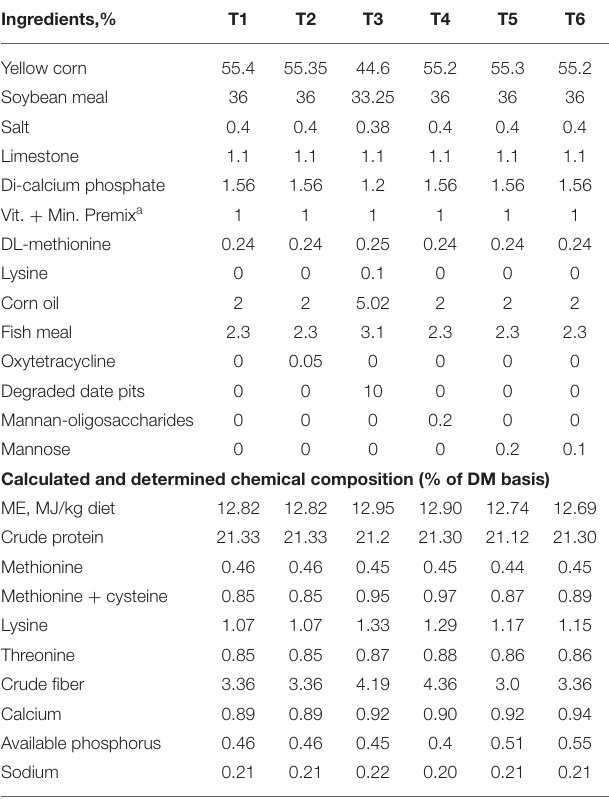
TABLE 1 | Composition and calculated chemical analysis of experimental starter diets on dry matter basis for broilers. Ingredients,% T1 T2 T3 T4 T5 T6 Yellow corn 55.4